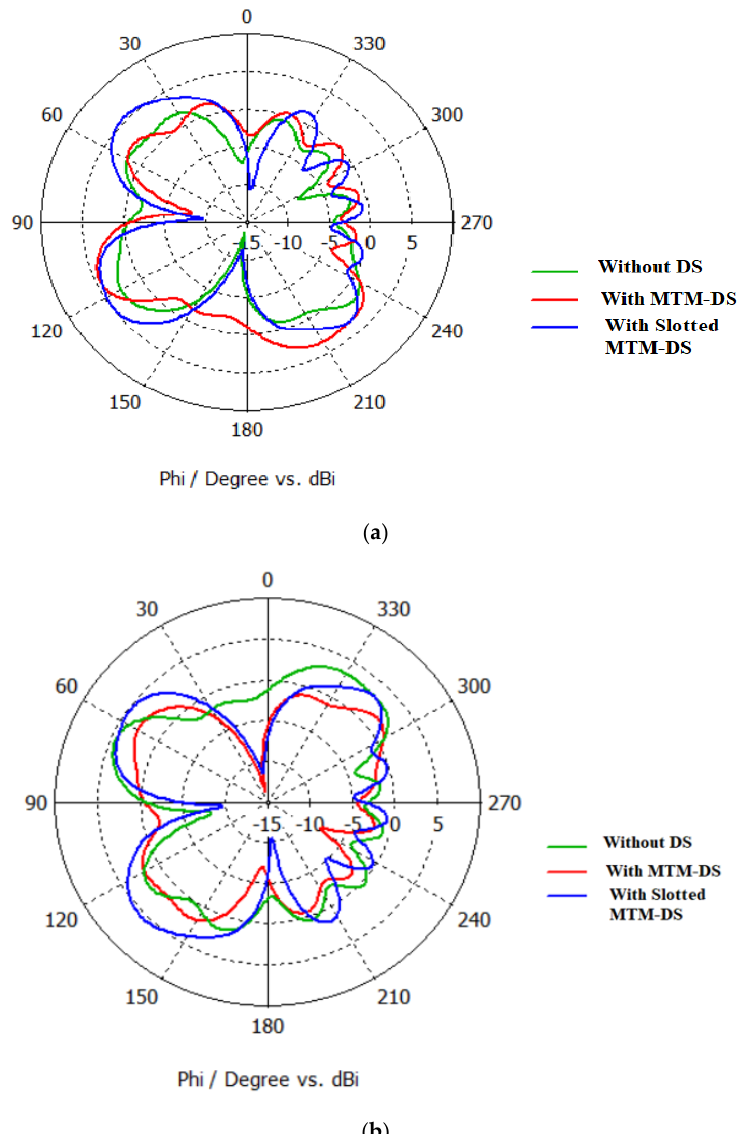
Figure 12. Simulated polar plots of the antenna array without DS, with MTM-DS, and with slotted MTM-DS ( a ) Antenna element #1 ( b ) Antenna element #2.